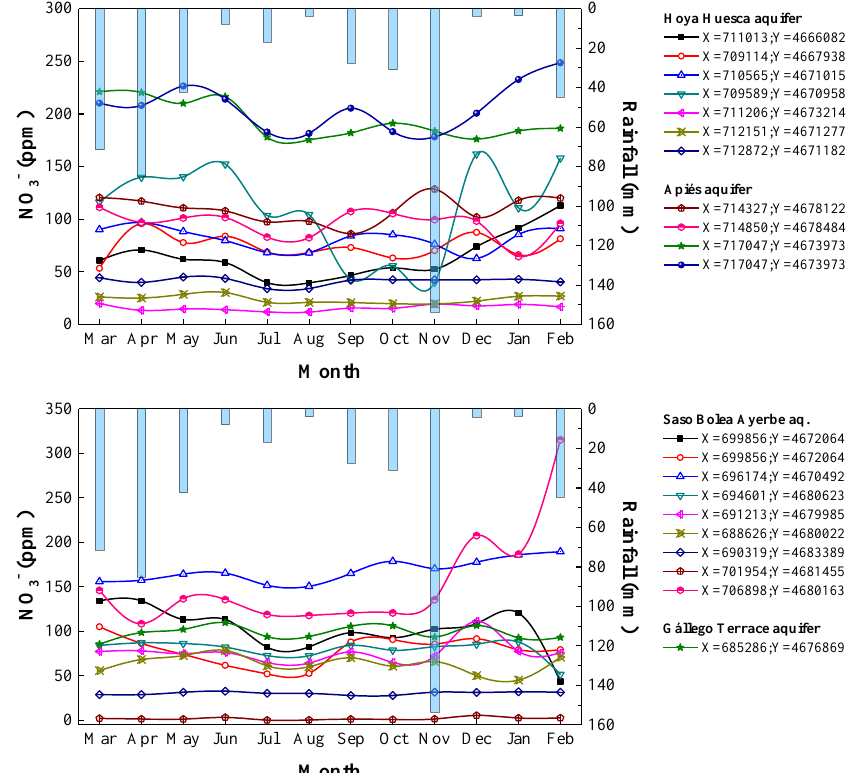
Figure 6. Nitrate content evolution in selected GW sampling points in Hoya de Huesca, Saso de Bolea-Ayerbe, Apiés, and Gállego Terrace aquifers form March 2016 until February 2017. Note that the vertical scale is different in the two plots. All coordinates in the legend refer to UTM zone 30N.